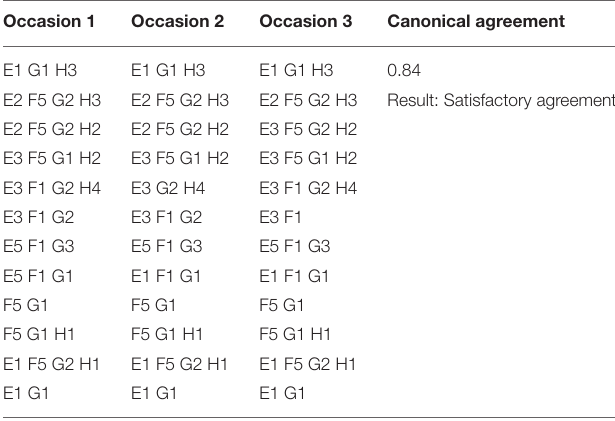
TABLE 4 | Example of datasets used to calculate intraobserver canonical